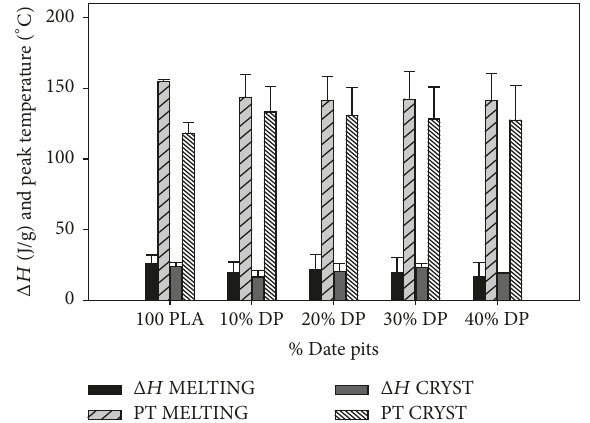
Figure 4: Effect of date pits on Δ𝐻 and peak temperature of melting and crystallization of PLA.